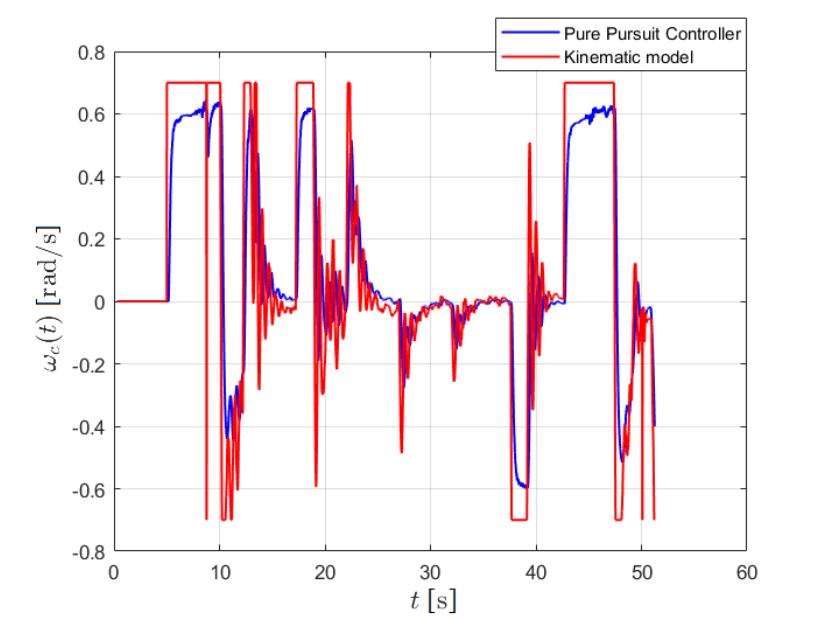
Figure 26. Angular velocity ω c ( t ) of the QBot 2e